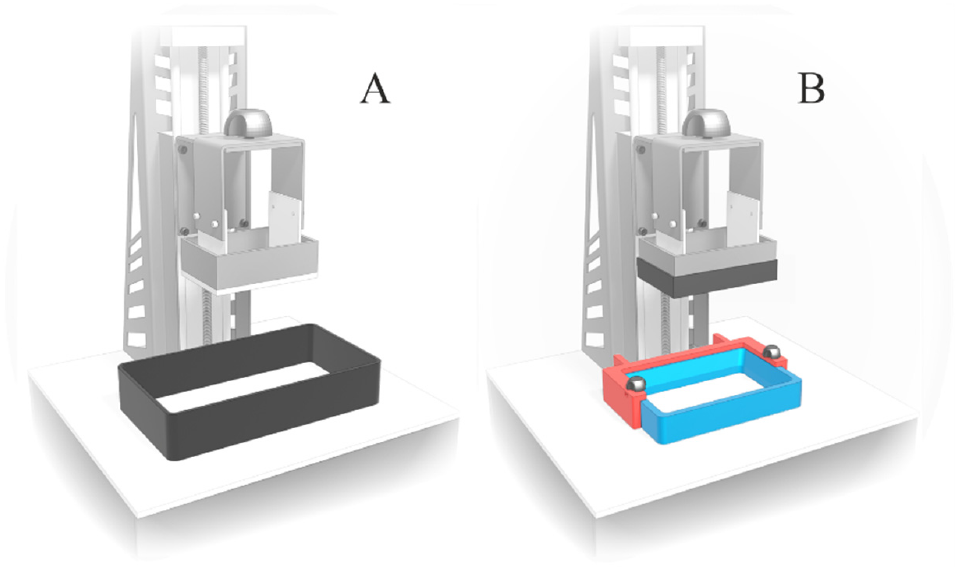
Figure 4. 3D printer structure: ( A )—original; ( B )—adapted: an overlay on printer platform (black), replaced resin tank with handle (marked blue and red, respectively).